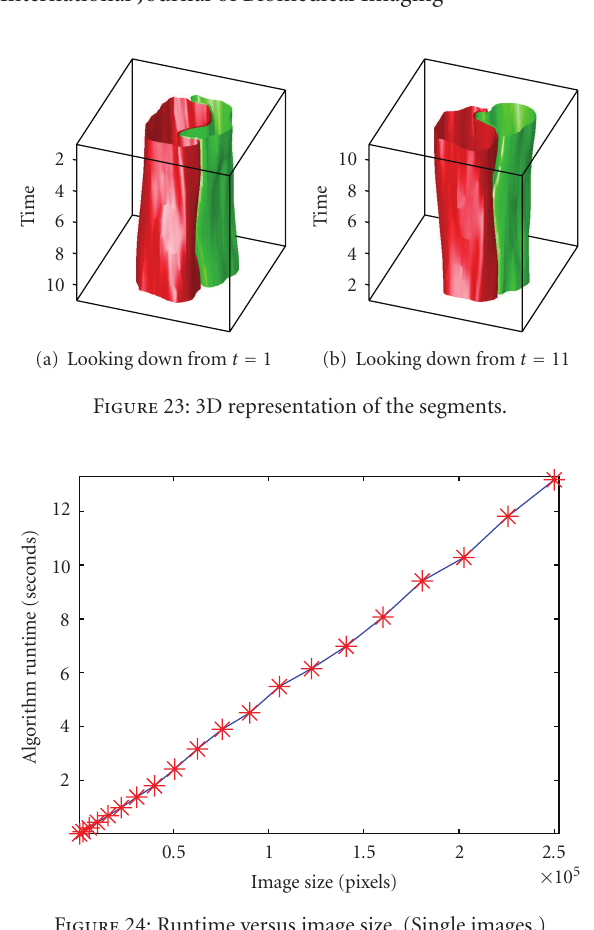
Figure 24: Runtime versus image size. (Single images.)